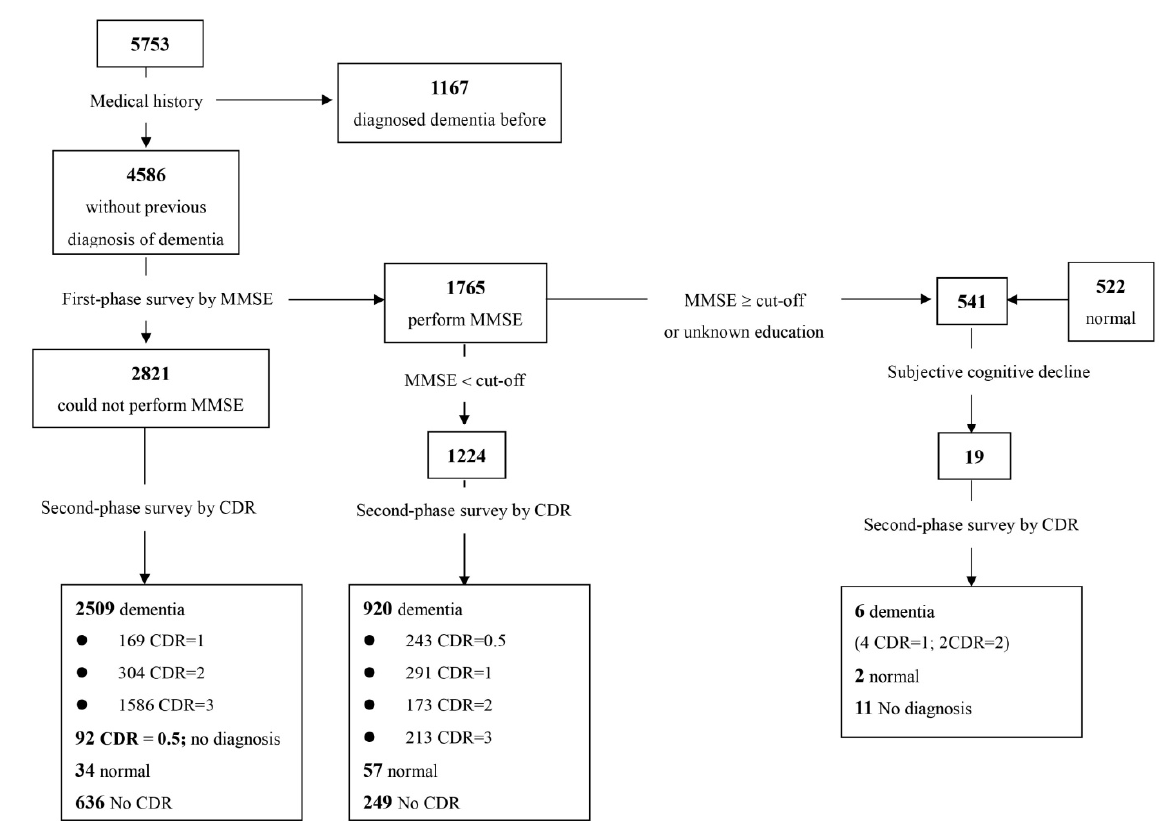
Figure 1. Schematic flow diagram of the sample size.